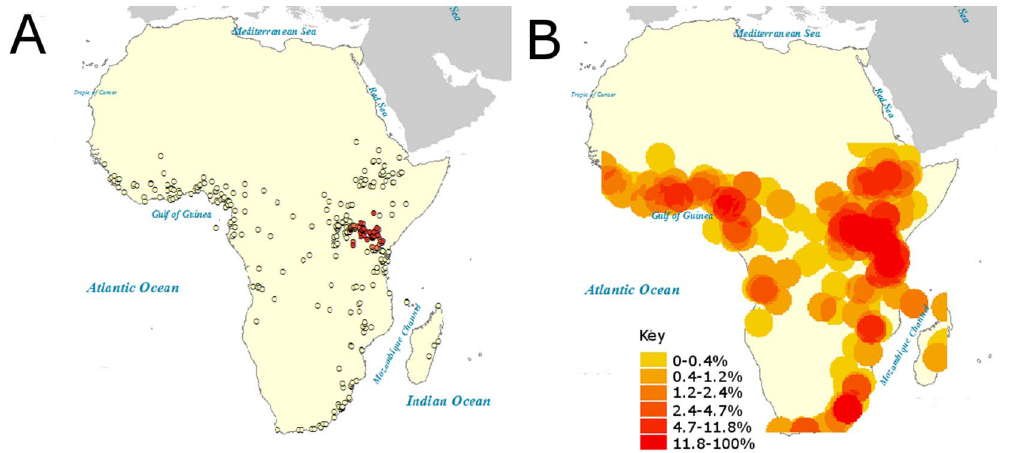
Figure 3. Summary of collection sample density. A) Hotspot analysis showing density outliers. Red dots indicate density more than 2.5 standard deviations above the average. No locations were labelled as outliers with low density. B) Heatmap of sampling density across Africa using circles of radius 280 km. Circles are coloured according to a scale of 7 quantile classes, which are labelled in the key with the proportion of density variation contained within each class.